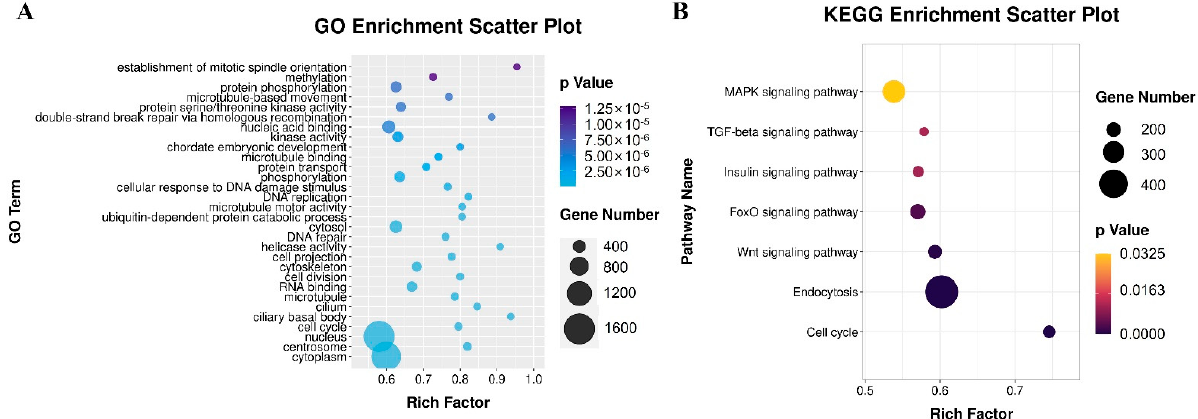
Figure 7. Gene Ontology (GO) and Kyoto Encyclopedia of Genes and Genomes (KEGG) enrichment analysis in gonad tissue between amh -down-regulated and control groups. ( A ) Top 30 GO catalogs of differentially expressed genes (DEGs) in testis tissues (treatment groups vs. control groups). Each annotated sequence was assigned at least one GO term in one of biological process, cellular component, or molecular function categories. ( B ) Significantly enriched KEGG pathways associated with cell development and metabolism in Nile tilapia under knocked-down amh (treatment groups vs. control groups). 3.6.2. TGF-Beta Signaling Pathway RNA sequencing revealed the TGF-beta signaling pathway to contain multiple DEGs related to embryonic development, fish growth, and the development and regulation of testes. Multiple sex-determining genes in fish were members of this pathway. The KEGG analysis revealed 112 DEGs to be involved in the TGF-beta signaling pathway under knocked-down amh (Figure S4). Among the top 20 DEGs, the expression levels of growth differentiation factor 2 ( gdf2 ), smad family member 6b ( smad6b ), and bone morphogenetic protein 2b ( bmp2b ) were significantly up-regulated, and those of amh and smad family member 1 ( smad1 ) were significantly down-regulated (Figure 8).